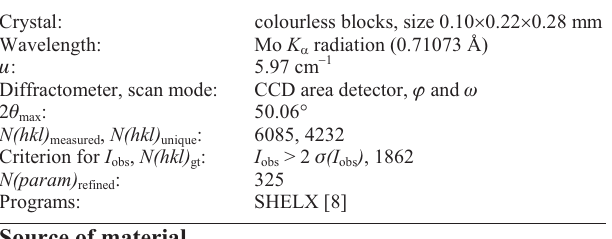
Table 1. Data collection and handling.